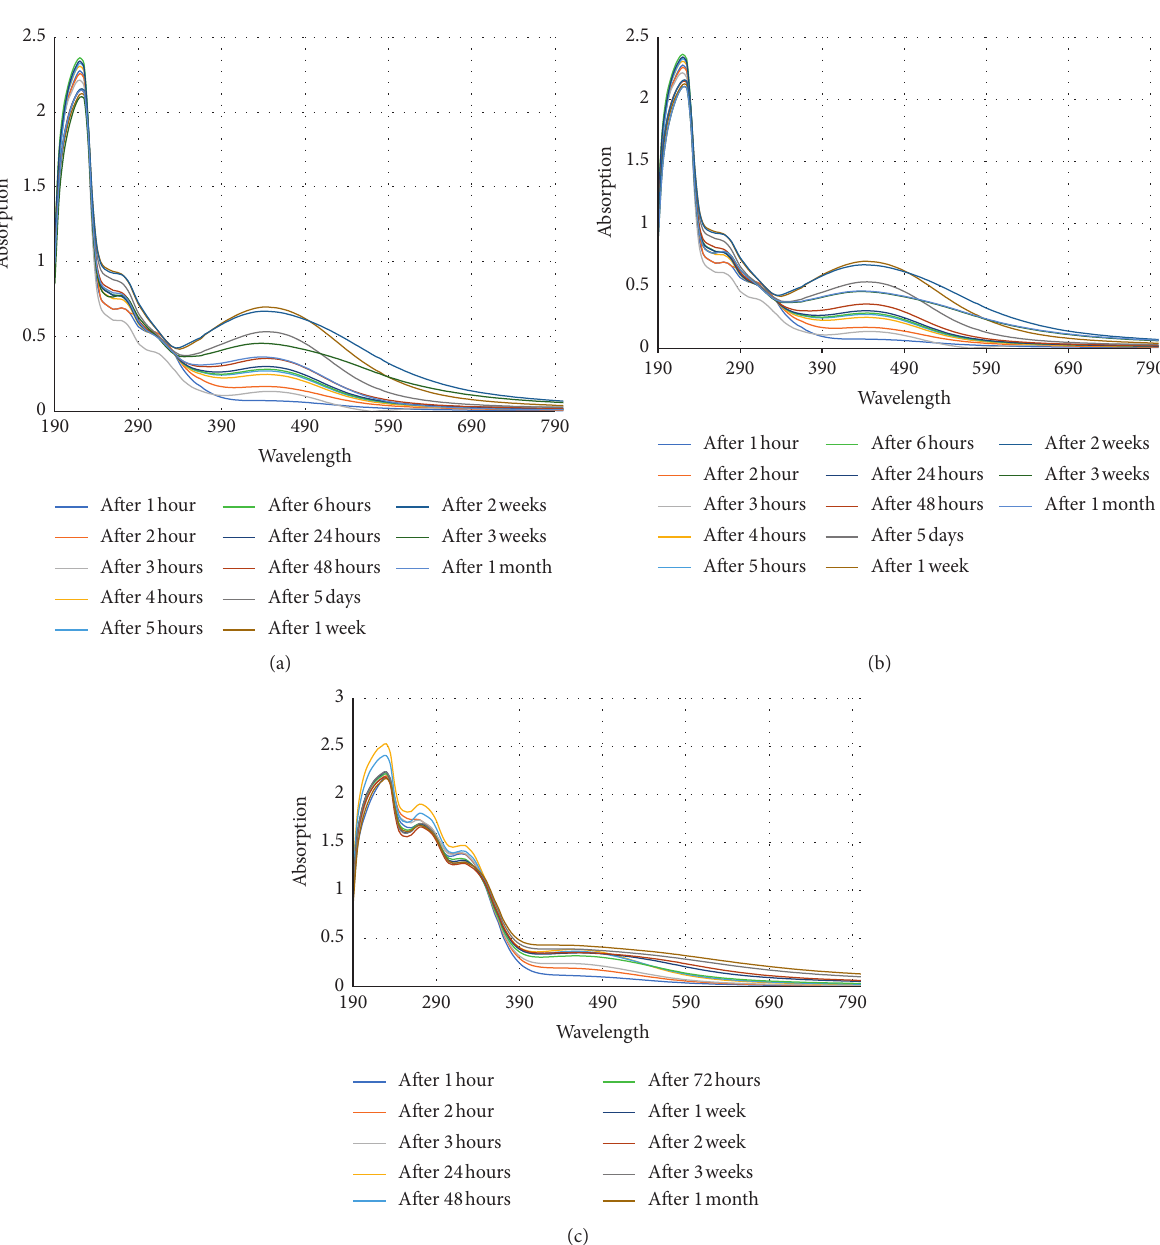
Figure 2: UV-visible spectrum recorded at different time intervals for 1 mM solution of silver nitrate with (a) lemon peel, (b) orange peel, and (c) green orange peel